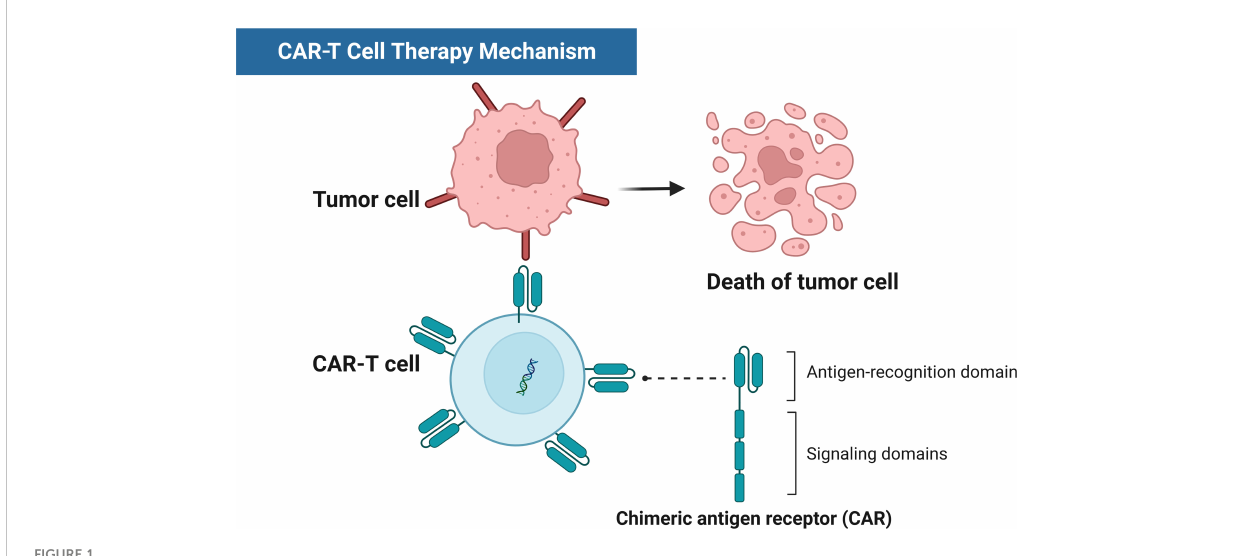
FIGURE 1 Schematic diagram of CAR-T therapy